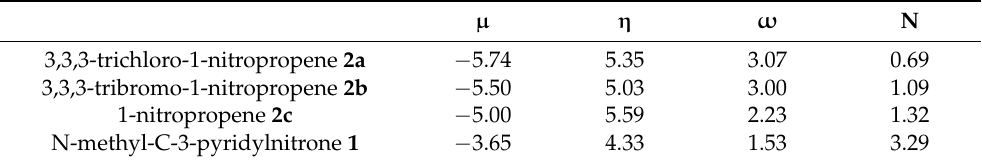
Table 1. The global reactivity descriptors calculated at the B3LYP/6-31G(d) level of theory. The electronic chemical potential µ , chemical hardness η , electrophilicity ω , and nucleophilicity N of studied